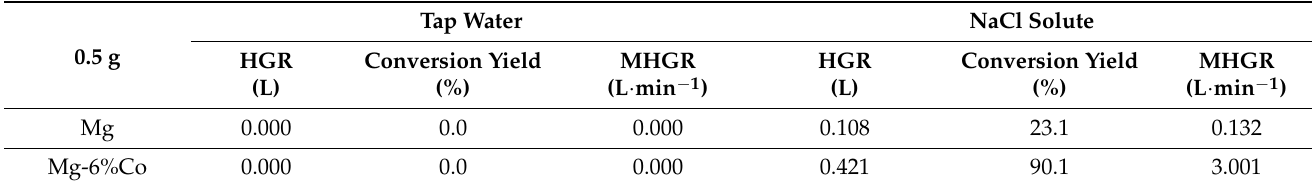
Table 3. Hydrogen generation properties of ball-milled Mg-6%Co with water and NaCl solute.